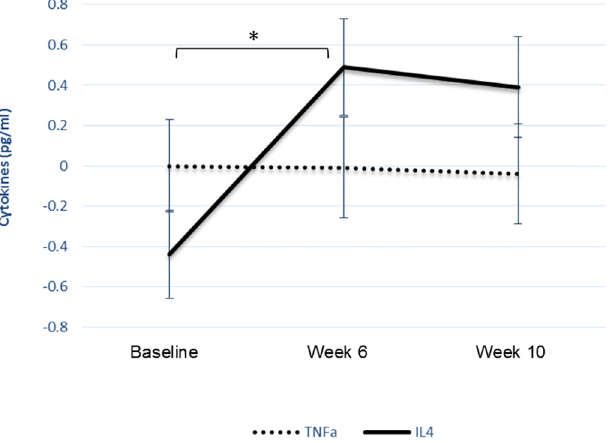
Fig 4. Pro- vs anti-inflammatory responses. Mean z scores for TNF α and IL4 (with standard errors) in response to drumming across the 10 weeks.